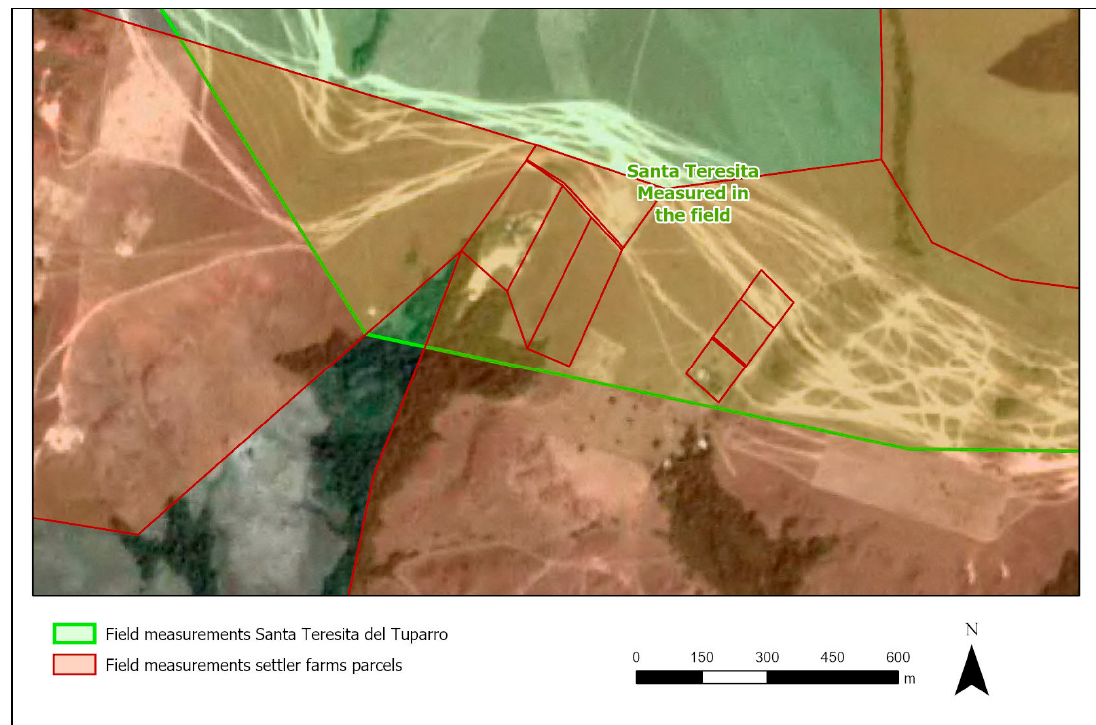
Figure 5. The Indigenous Santa Teresita del Tuparro reserve, as measured in the field by the Indigenous leaders compared to the parcels of the neighbouring settler farmers, as measured in the field: 1, La Guajira; 2, Buenavista; 3, Cuatro Vientos; 4, La Estancia; 5, Los Moriches; 6, Patio Bonito; 7, military base; 8, sold lots; 9, El Basurero (the municipal garbage belt).